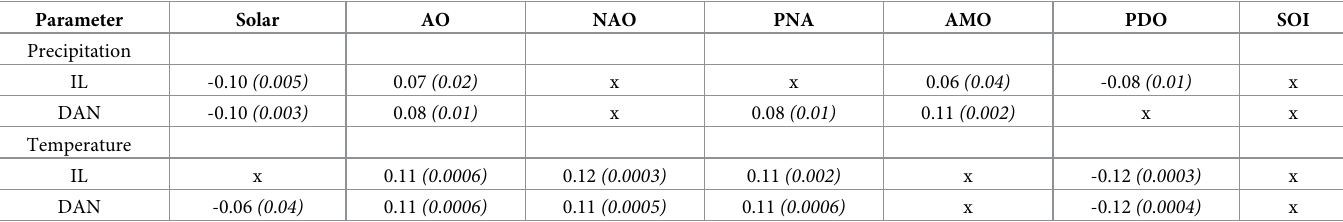
IL, DAN = Indian Lake and Dannemora stations, respectively. P-values in parentheses. x indicates no significant correlation. Solar = solar flux. AO = Arctic Oscillation. NAO = North Atlantic Oscillation. PNA = Pacific North American pattern. AMO = Atlantic Meridional Oscillation. PDO = Pacific Decadal Oscillation. SOI = Southern Oscillation